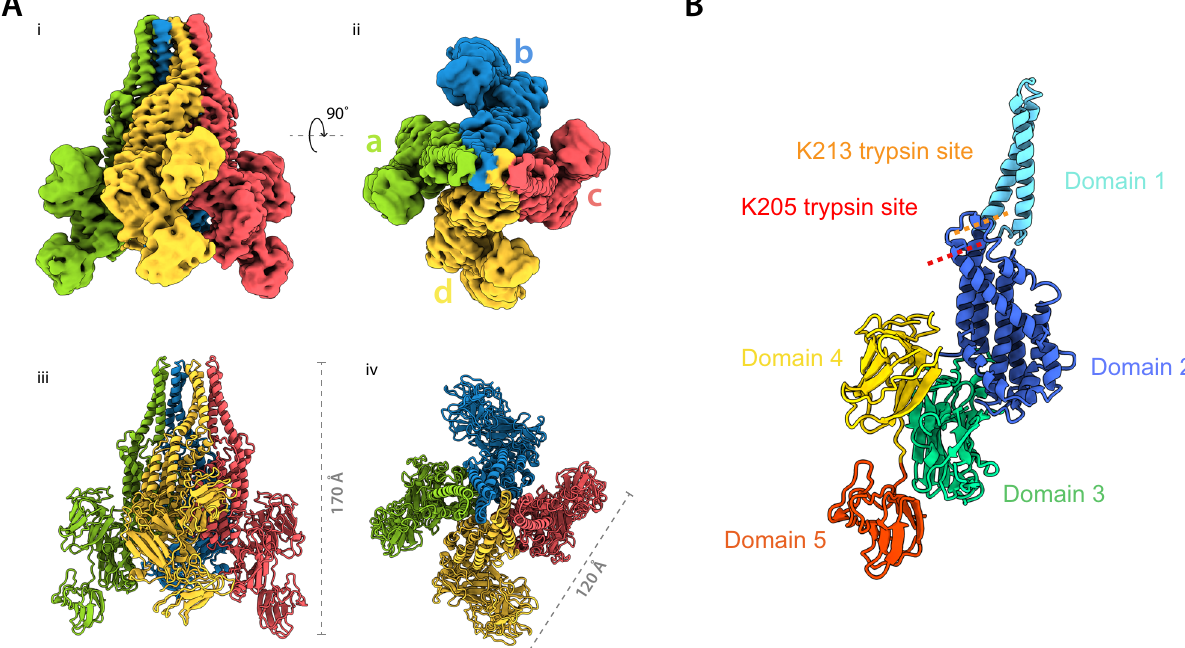
Fig. 1 Structure of Vip3Bc1. A Quaternary structure of Vip3Bc1 tetramer as shown from two views of the complex related by 90° for the EM density (i, ii) and model (iii, iv). B Model of Vip3Bc1 illustrating domain structure as a monomer. The model shown corresponds to subunit A. Primary trypsin processing site K205 is indicated. Domain structure with respect to the primary sequence can be seen in Supplementary Fig.